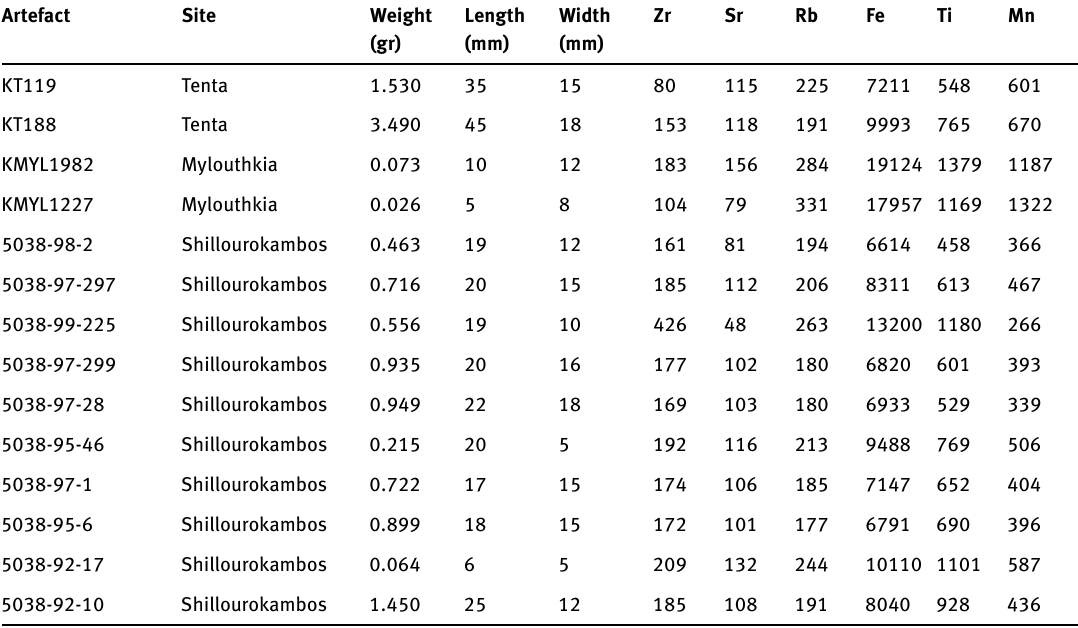
Table 1. The table summarises metrical (weight and maximum dimensions) and elemental data (in ppm) for each of the fifteen outliers discussed in the text. With the exception of KMYL1227, 5038-95-46 and 5038-92-17 all artefacts are large enough to disregard machine-induced